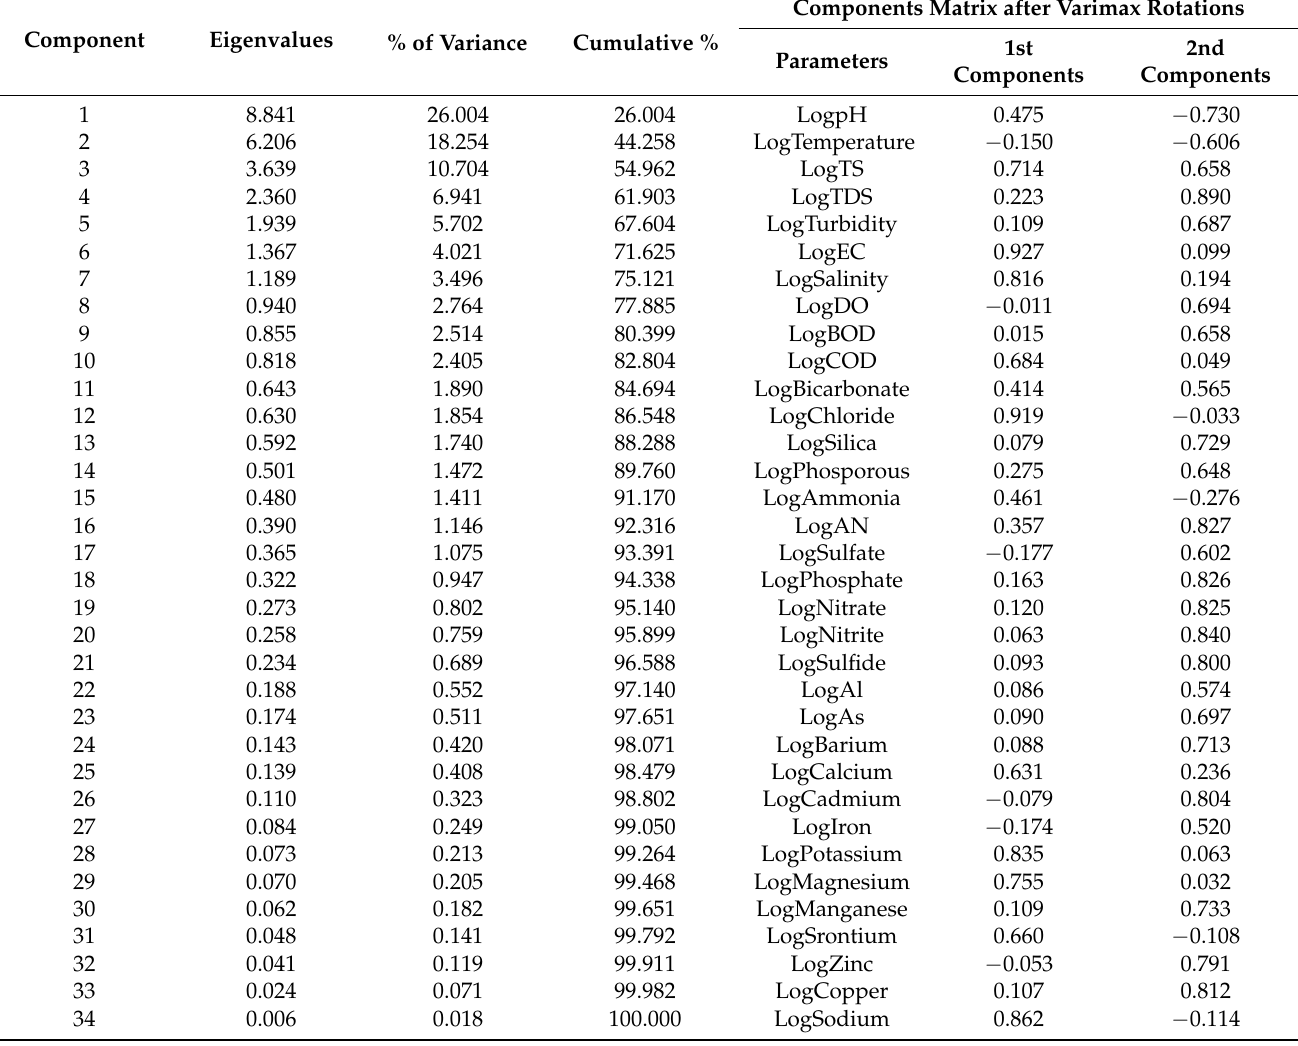
Table 5. The values of the total variance and rotated components matrix for preliminary